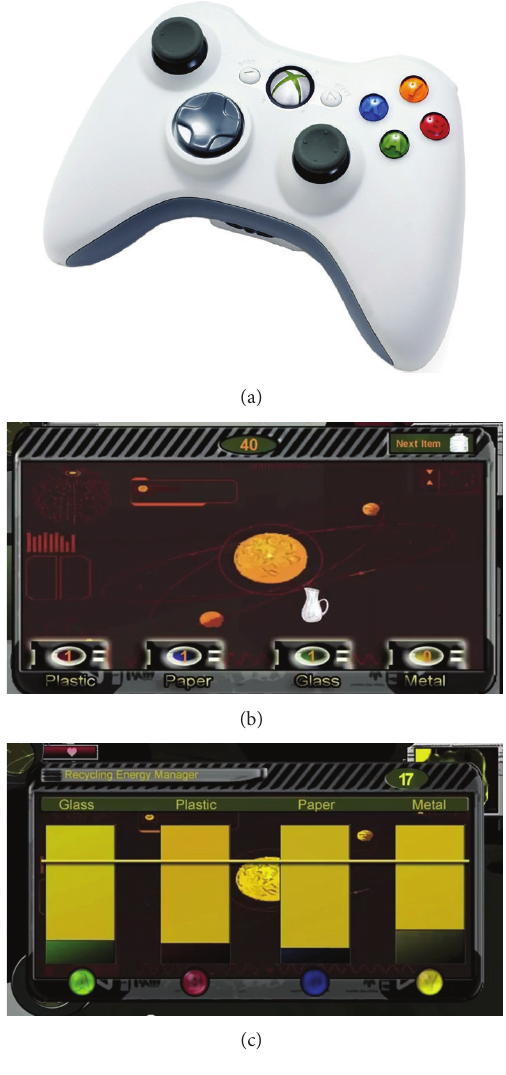
Figure 9: Xbox controller and two examples of learning mech- anisms from level 1: (a) Xbox command; (b) associated to the separation of garbage; (c) energy bar levels associated to the recycling machines.